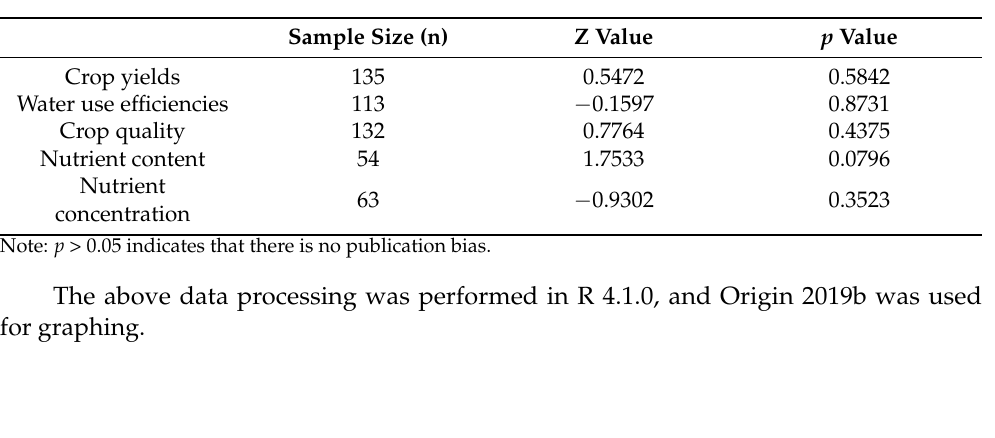
Table 1. Publication bias test of relevant data—Egger’s